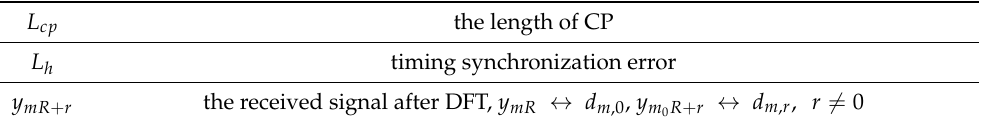
Table 1. Cont. L cp the length of CP